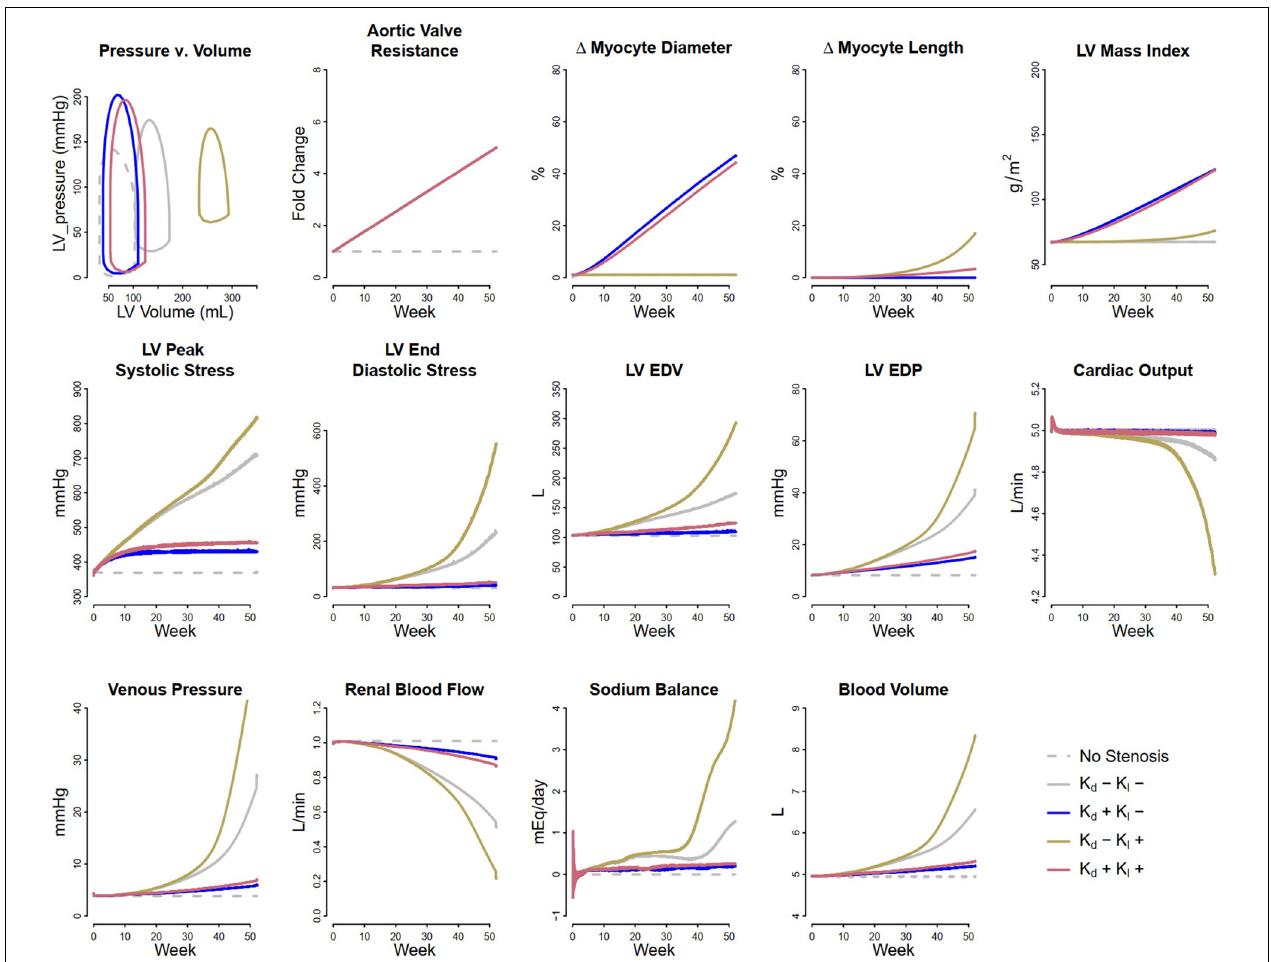
FIGURE 2 | Simulated response to pressure overload due to aortic stenosis under different remodeling assumptions. Gray dashed, baseline, no stenosis; Gray solid, no remodeling; Blue, only myocyte diameter allowed to change (K d0 > 0, K l0 = 0); Brown, only myocyte length allowed to change (K d0 = 0, K l0 > 0); Red, both myocyte diameter and myocyte length allowed to change (K d0 and K l0 >